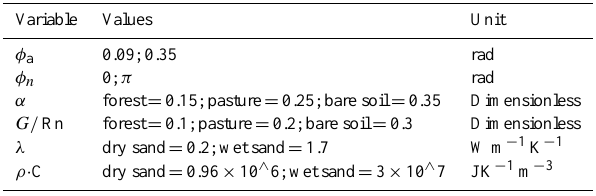
Table 9. Statistics of the test 1 (values in K). Error statistics of T a estimates over 2007 to 2009 using the mean of the Fourier coeffi- cients from 2000 to 2006 against T a